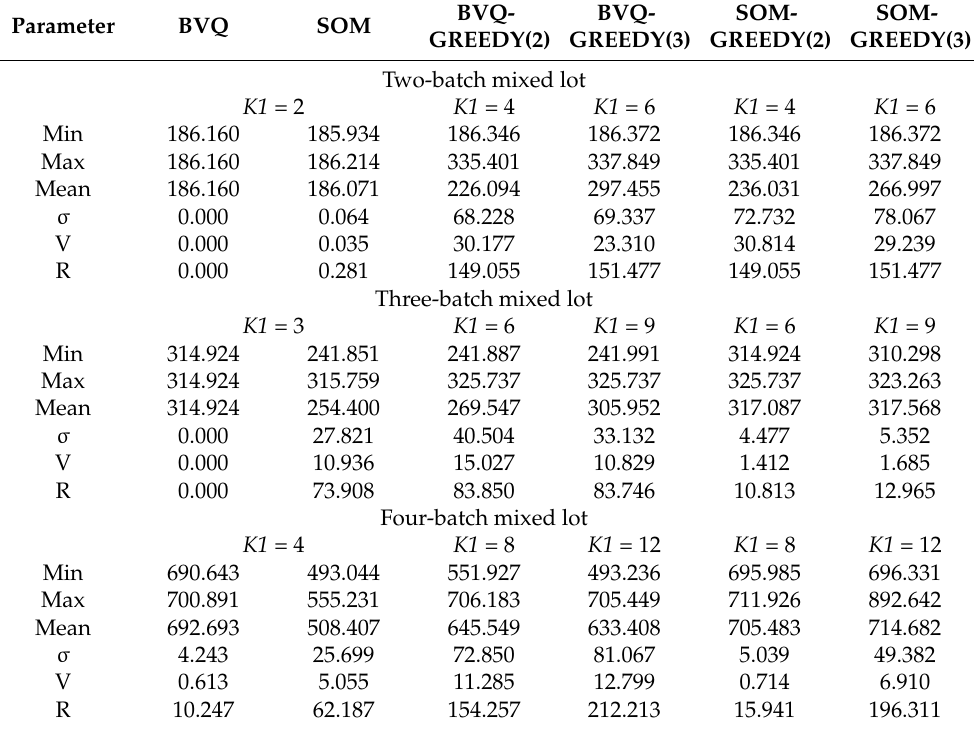
Table A14. Objective function value summarized after 30 attempts (Manhattan distance, initialization by